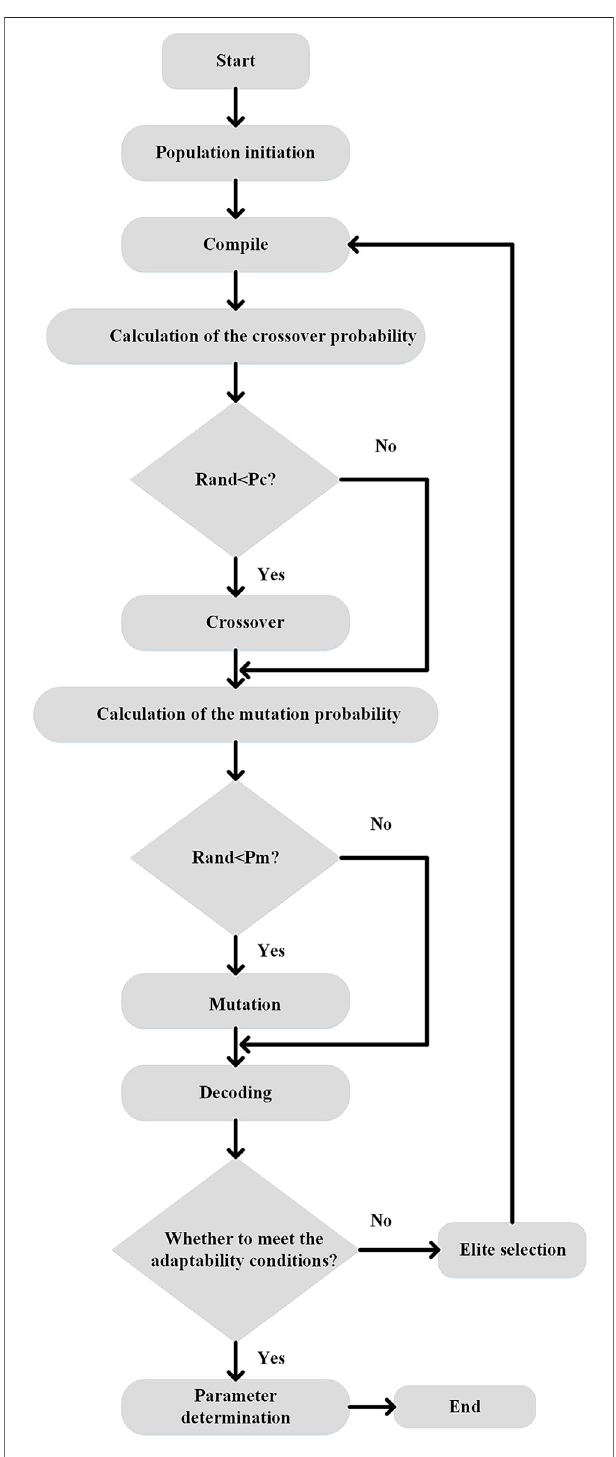
FIGURE 5 | Schematic diagram of the